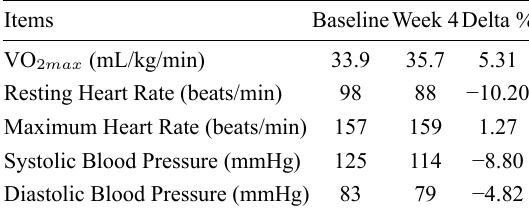
Table 5. Changes in cardiopulmonary